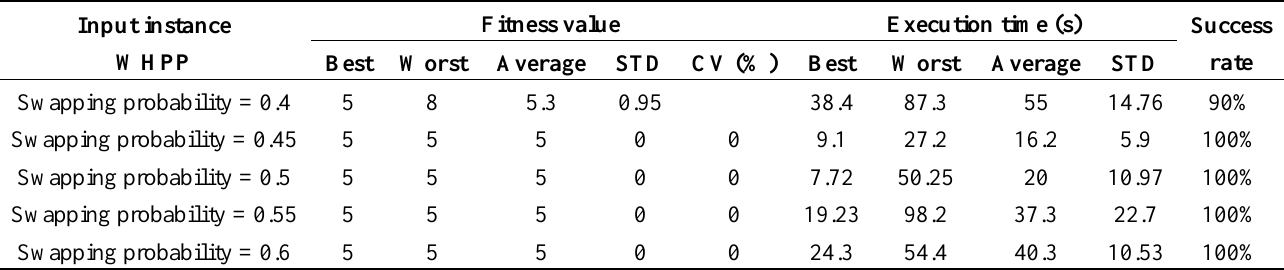
Table 22. Investigating the effect of swapping probability for input instance, WHPP.